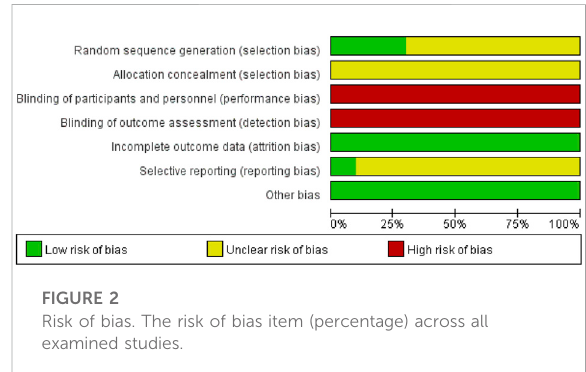
FIGURE 2 Risk of bias. The risk of bias item (percentage) across all examined studies.